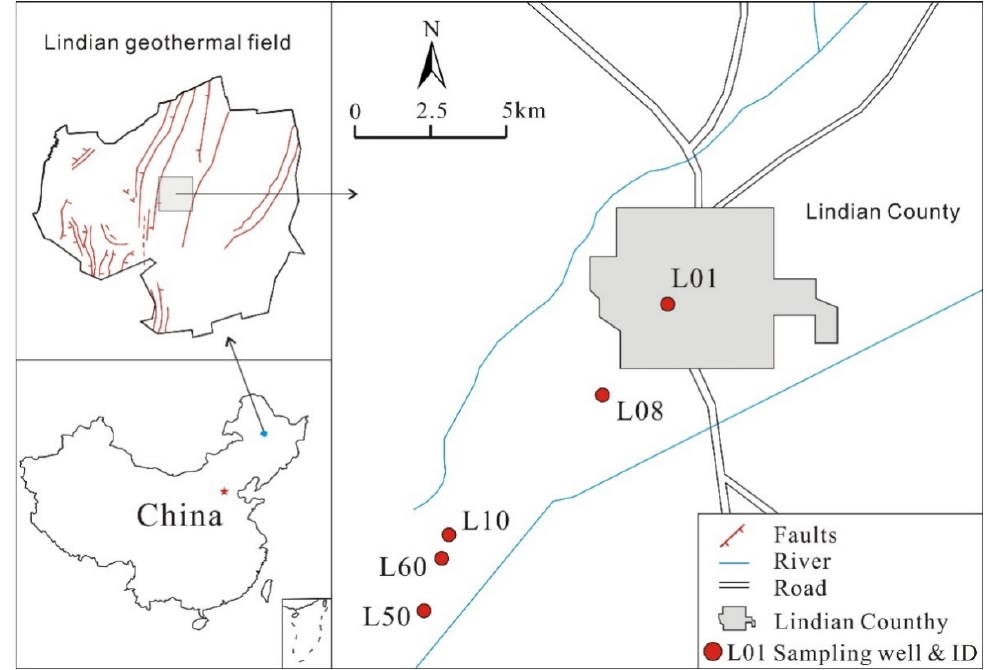
Figure 1. Location of the Lindian geothermal field and sampling wells.